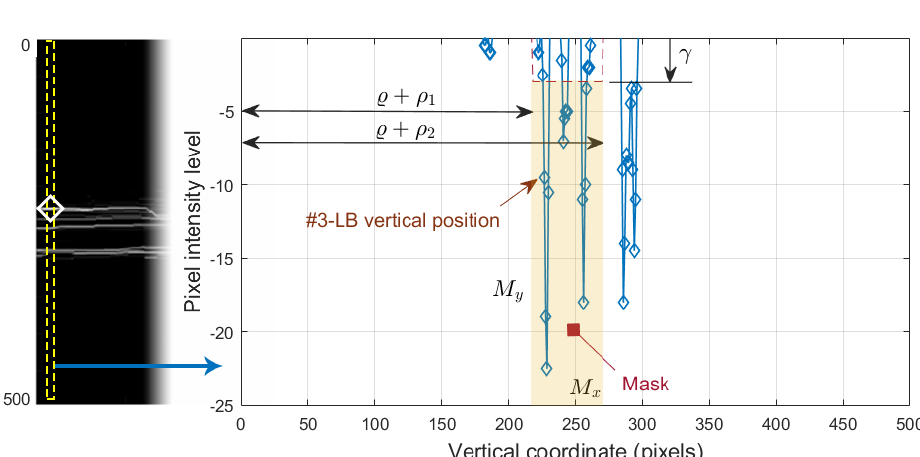
Figure 13. Selection of the #3-LB vertical position. On the left, the negative vertical gradient image I #3 . On the right, 1D profile of the dashed column of I #3 9